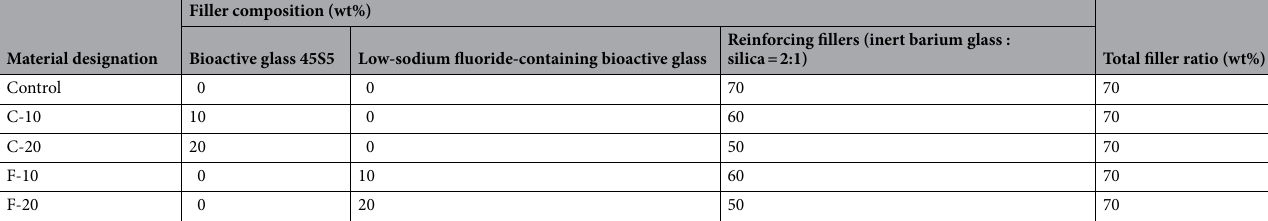
Table 2. Composition of experimental resin composites.